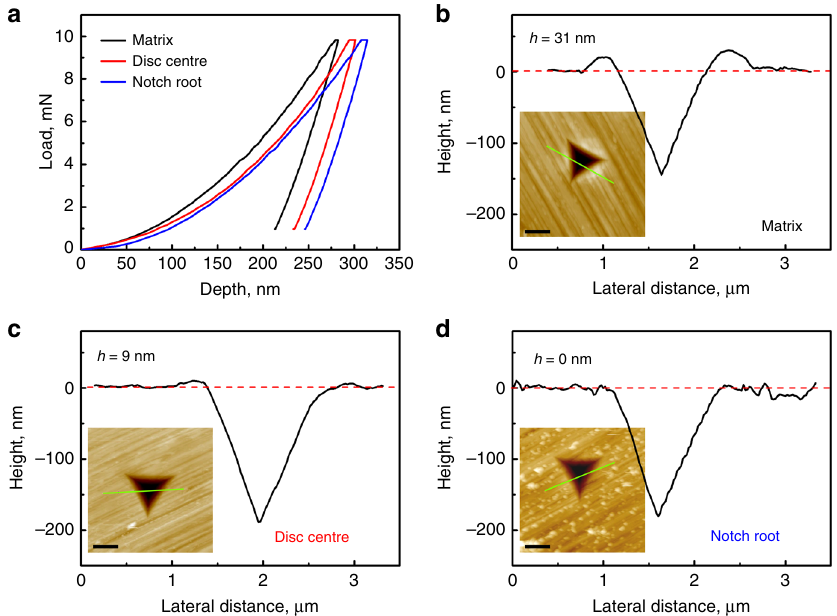
Fig. 5 Nanoindentation of a deformed glass. A notched specimen was subjected to 40% compressive strain (axial strain in the disc de fi ned by the notch) at RT. a loading/unloading curves for indentation of the matrix (on a specimen cross-section away from the notch region), at the centre of the circular face of the deformed disc sectioned from the deformed specimen (Supplementary Fig. 3), and at the edge of the circular face (the notch root). b – d For these three locations, AFM line-scans and images of indents show a progressive decrease in the height ( h ) of the pile-up, which disappears in the region of the notch root. The scale bars in the insets of b – d are 1 μ m